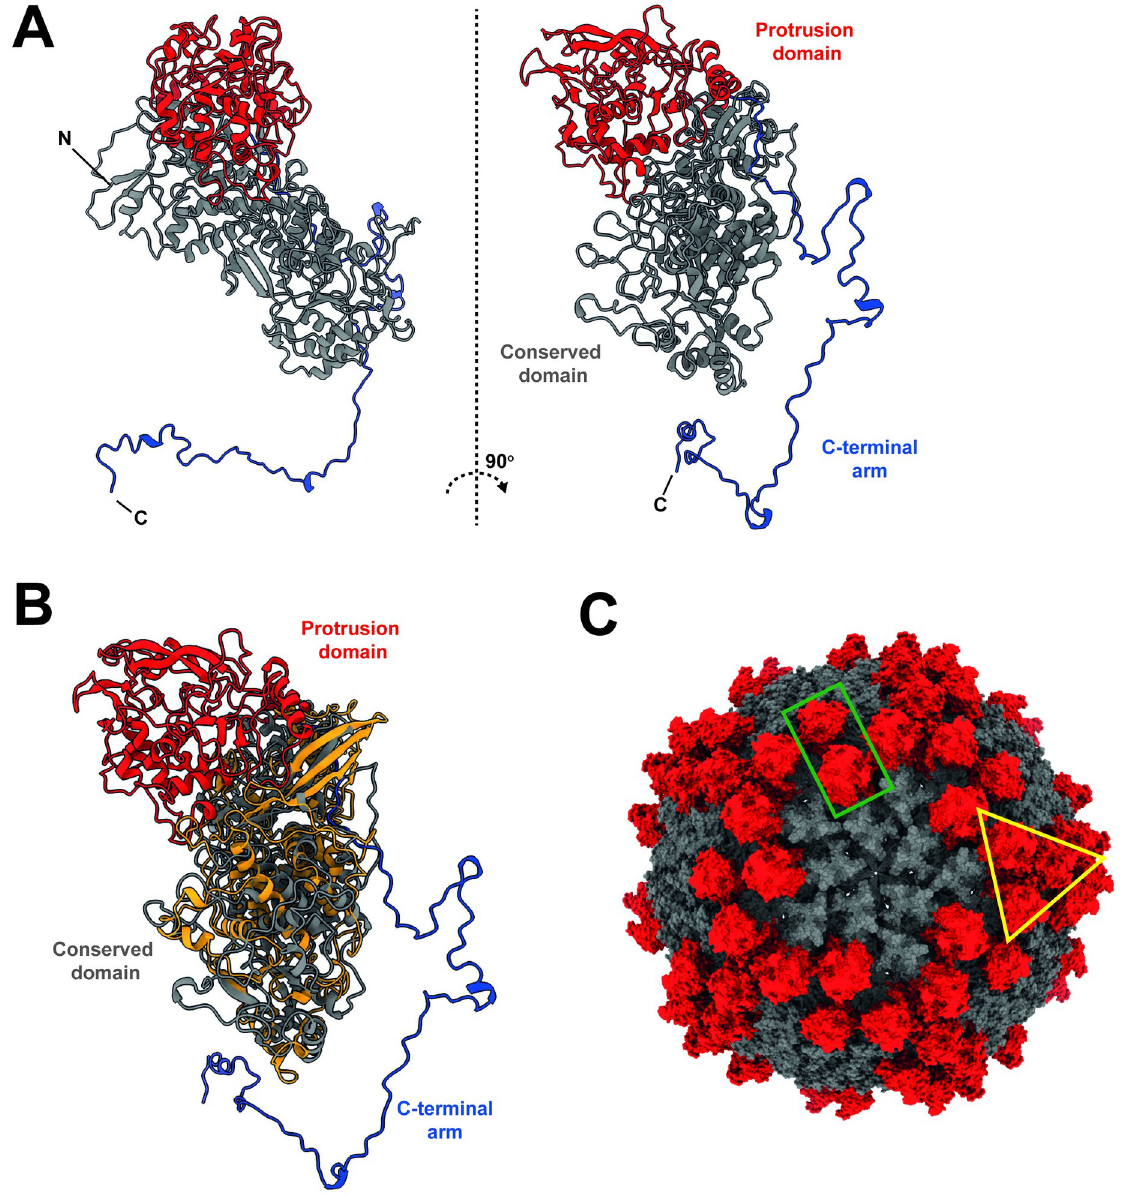
Fig 3. Unique protrusion domain of the RnMBV1 MCP. A) Domain organization in the atomic model of the MCP. The protrusion domain, conserved domain, and extra-long C-terminal arm are colored red, gray, and dark blue, respectively. B) Superimposition of RnMBV1 MCP (colored by the domains corresponding to panel A) and ScV-L-A CP (orange). C) Locations of the protrusion domains on the capsid. The protrusion domains and conserved domains are colored red and gray, respectively. The green rectangle and yellow triangle display the protrusion domains formed by the MCP_A subunit dimer and the MCP_B subunit trimer, respectively. subunits form dimers on the capsid surface (green rectangle in Fig 3C), while those of MCP_B subunits cluster to build a trimer around each 3-fold axis (yellow triangle in Fig 3C). Such structural acquisitions of the protrusion domains seem to occur independently and uniquely in viruses which infect multicellular hosts in each family among toti-like virus OmRV [6,8], RnQV1 ( Quadriviridae ) [40], and RnMBV1 ( Megabirnaviridae ). The mosquito virus OmRV likely has acquired the protruded surface for an extracellular transmission, such